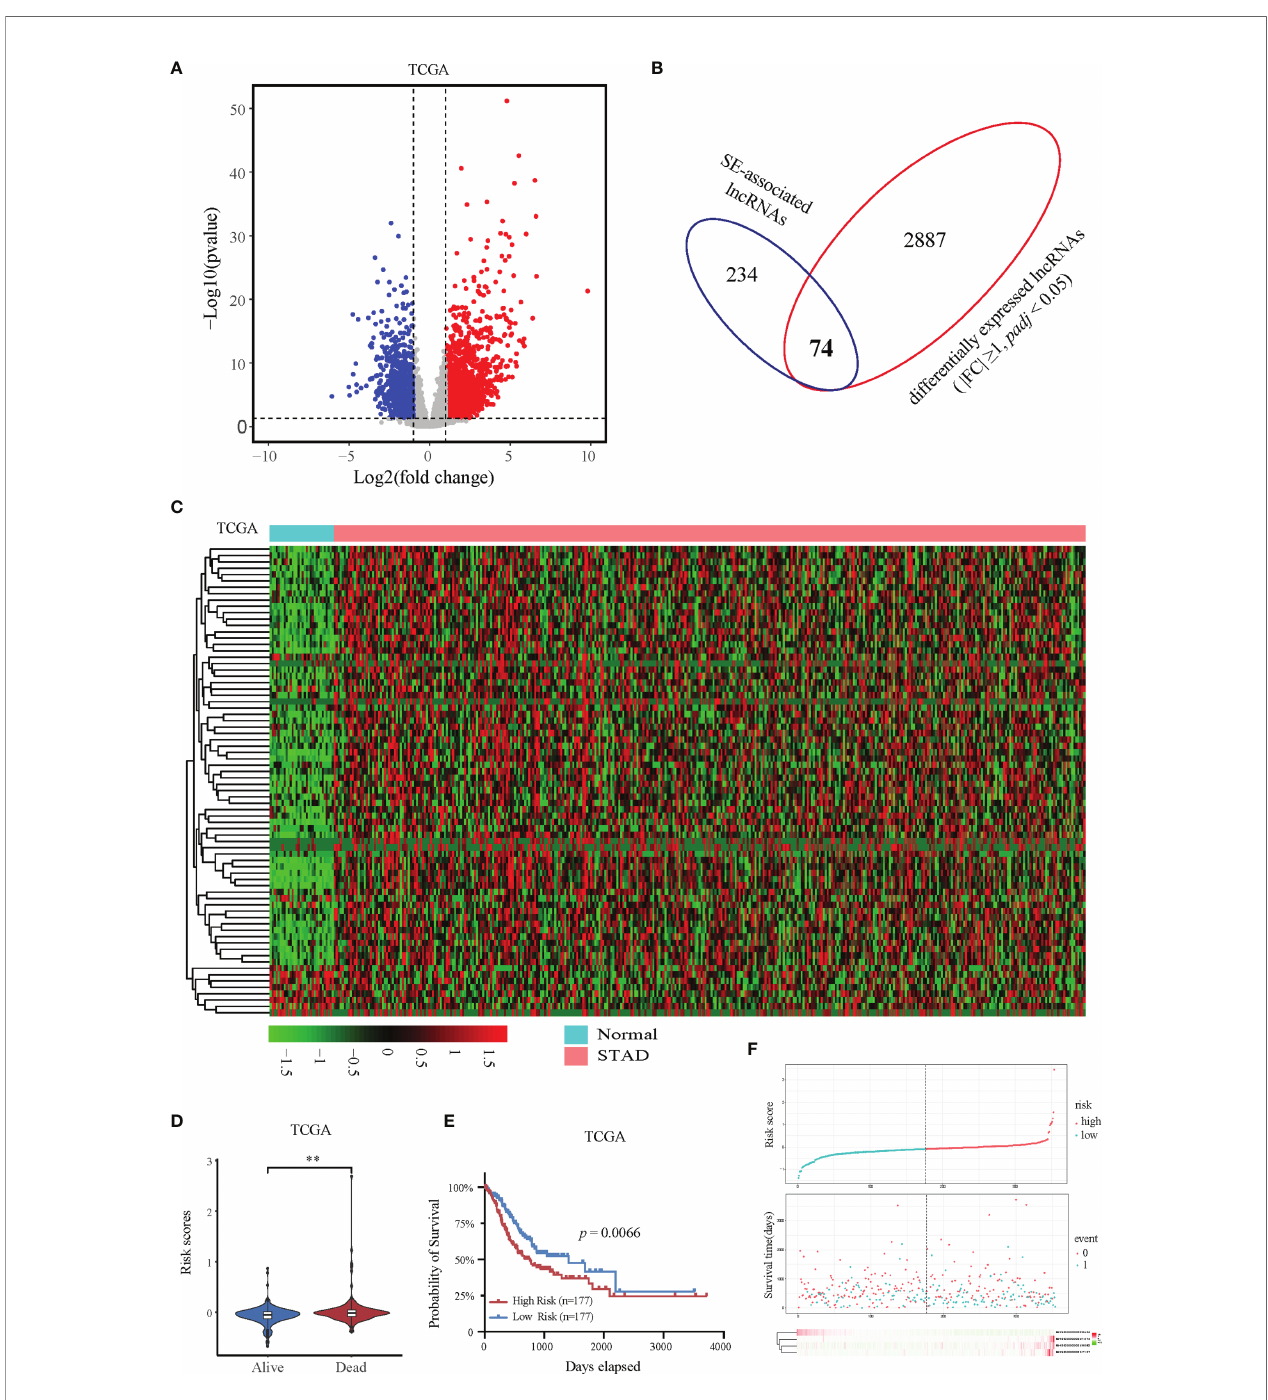
FIGURE 2 | Expression and prognostic analysis of super-enhancer-associated lncRNAs in patients with STAD. (A) Volcano plot showing the expression changes of SE-associated lncRNAs in STAD samples compared with normal stomach tissues. The red dots represent up-regulated lncRNAs (FC ≥ 1, Q value < 0.05), and the blue dots represent down-regulated lncRNAs in STAD patients (FC ≤ -1, Q value < 0.05). (B) Venn diagram representing the intersection of 2961 differentially expressed lncRNAs in patients with STAD and the 308 SE-associated lncRNAs identi fi ed above. (C) Expression pro fi ling of 74 differentially expressed SE-associated lncRNAs in human STAD samples and normal stomach tissues. (D) The risk scores of alive or dead STAD patients predicted by expression of SE-associated lncRNAs from TCGA dataset. (E) The prognosis of SE-associated lncRNAs in STAD patients with high risk and low risk based on the RiskScore signature. (F) The distributions of the four lncRNAs in groups between high and low risk in STAD patients. The top was the risk score of STAD patients calculated according to the RiskScore signature and split into two groups on basis of medium score. The middle represented the survival status. The bottom heatmap showed the differential pro fi le of four lncRNAs. The expression and clinical data of all lncRNAs were downloaded from TCGA database (https://www.cancer.gov/). **Indicates p <